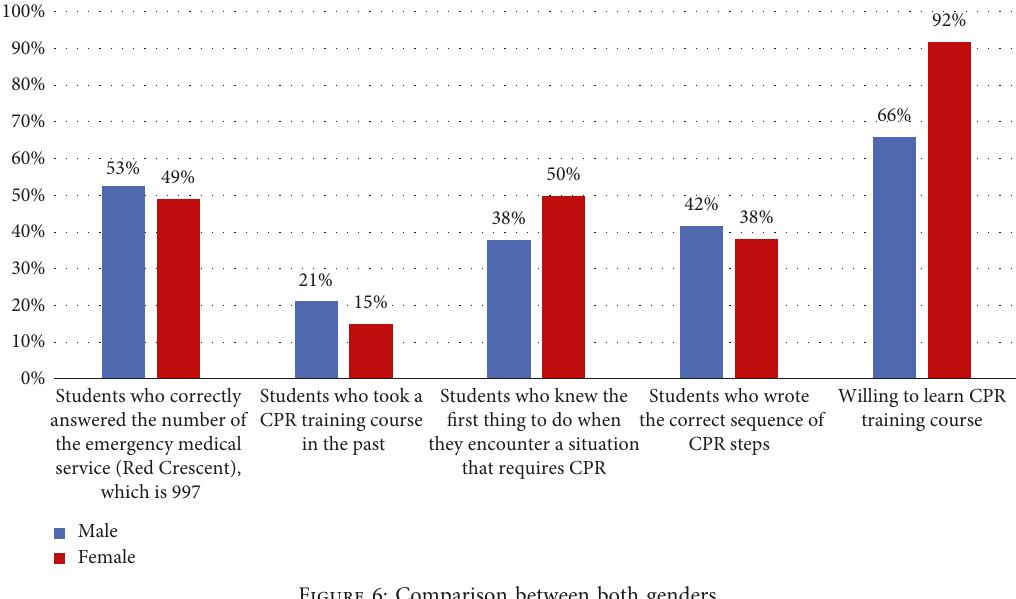
Figure 6: Comparison between both Table 8: Comparison between health-related colleges and non-health-related colleges.